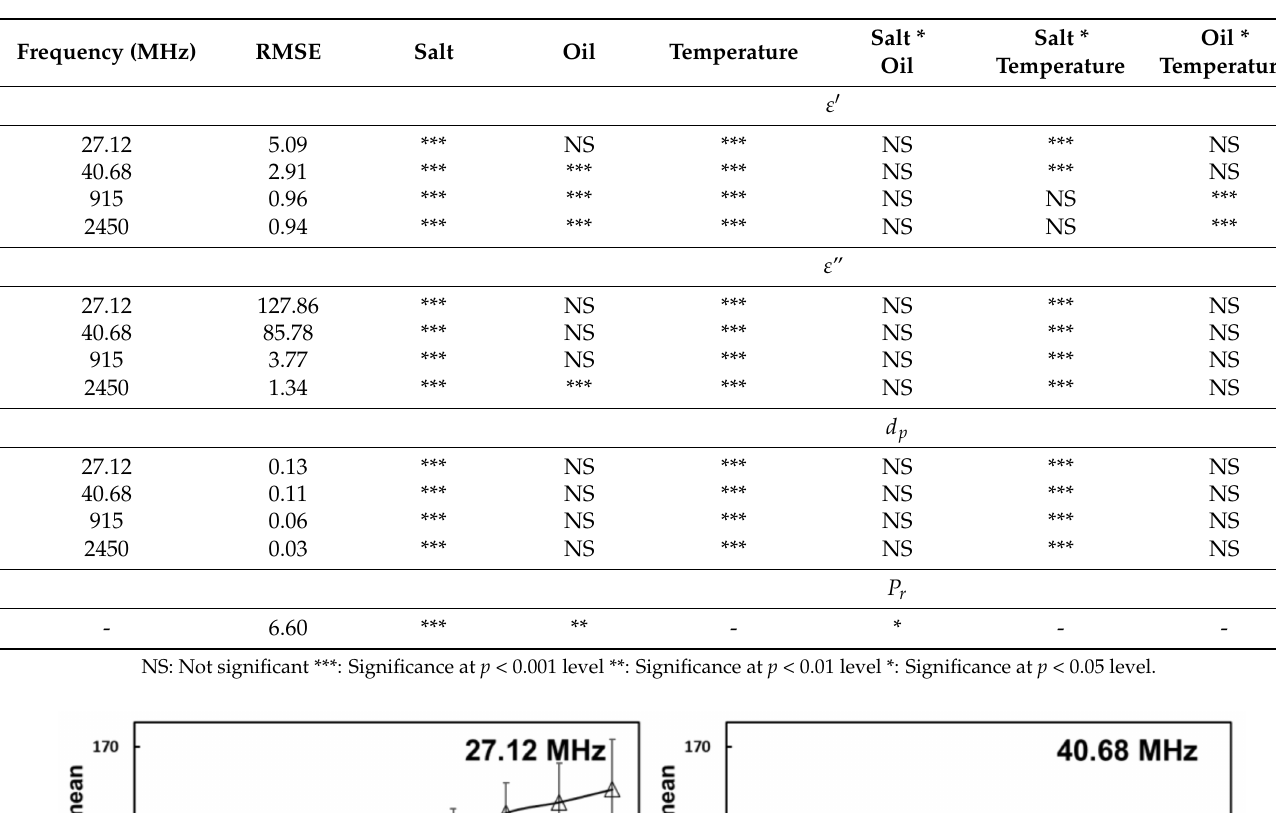
Table 1. Significance level and root mean square error (RMSE) of each factor studied in the least-squares fitting of dielectric constant, loss factor, and penetration depth of tomato, olive oil, and salt mixtures.